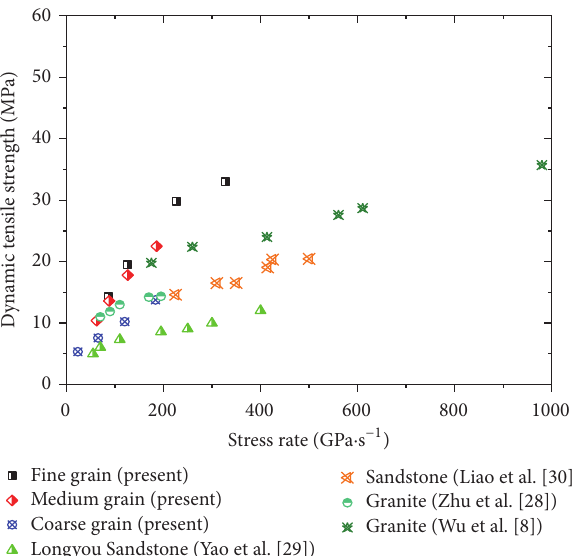
Figure 12: Dynamic Brazilian results obtained in this paper and their comparison to the existing results.